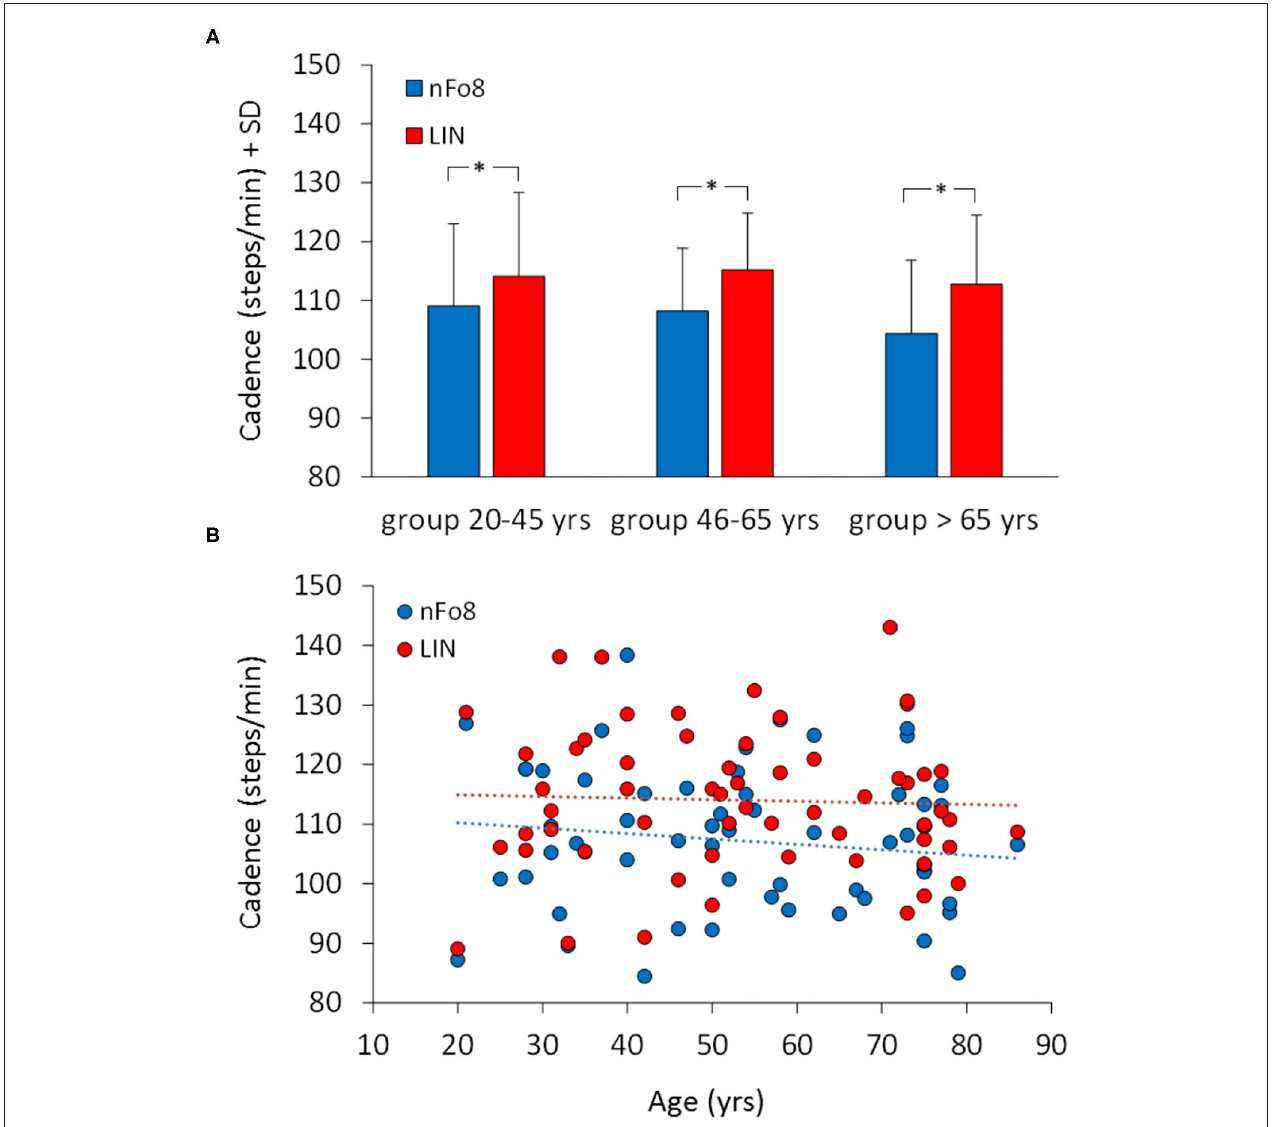
FIGURE 3 | Mean cadence in the three age groups (A) and the relationship between cadence and age across all participants (B) . Blue bars and dots belong to the nFo8, red bars and dots to the LIN. Cadence was lower during nFo8 than during linear walking in all the three groups of age. Asterisks indicate significant